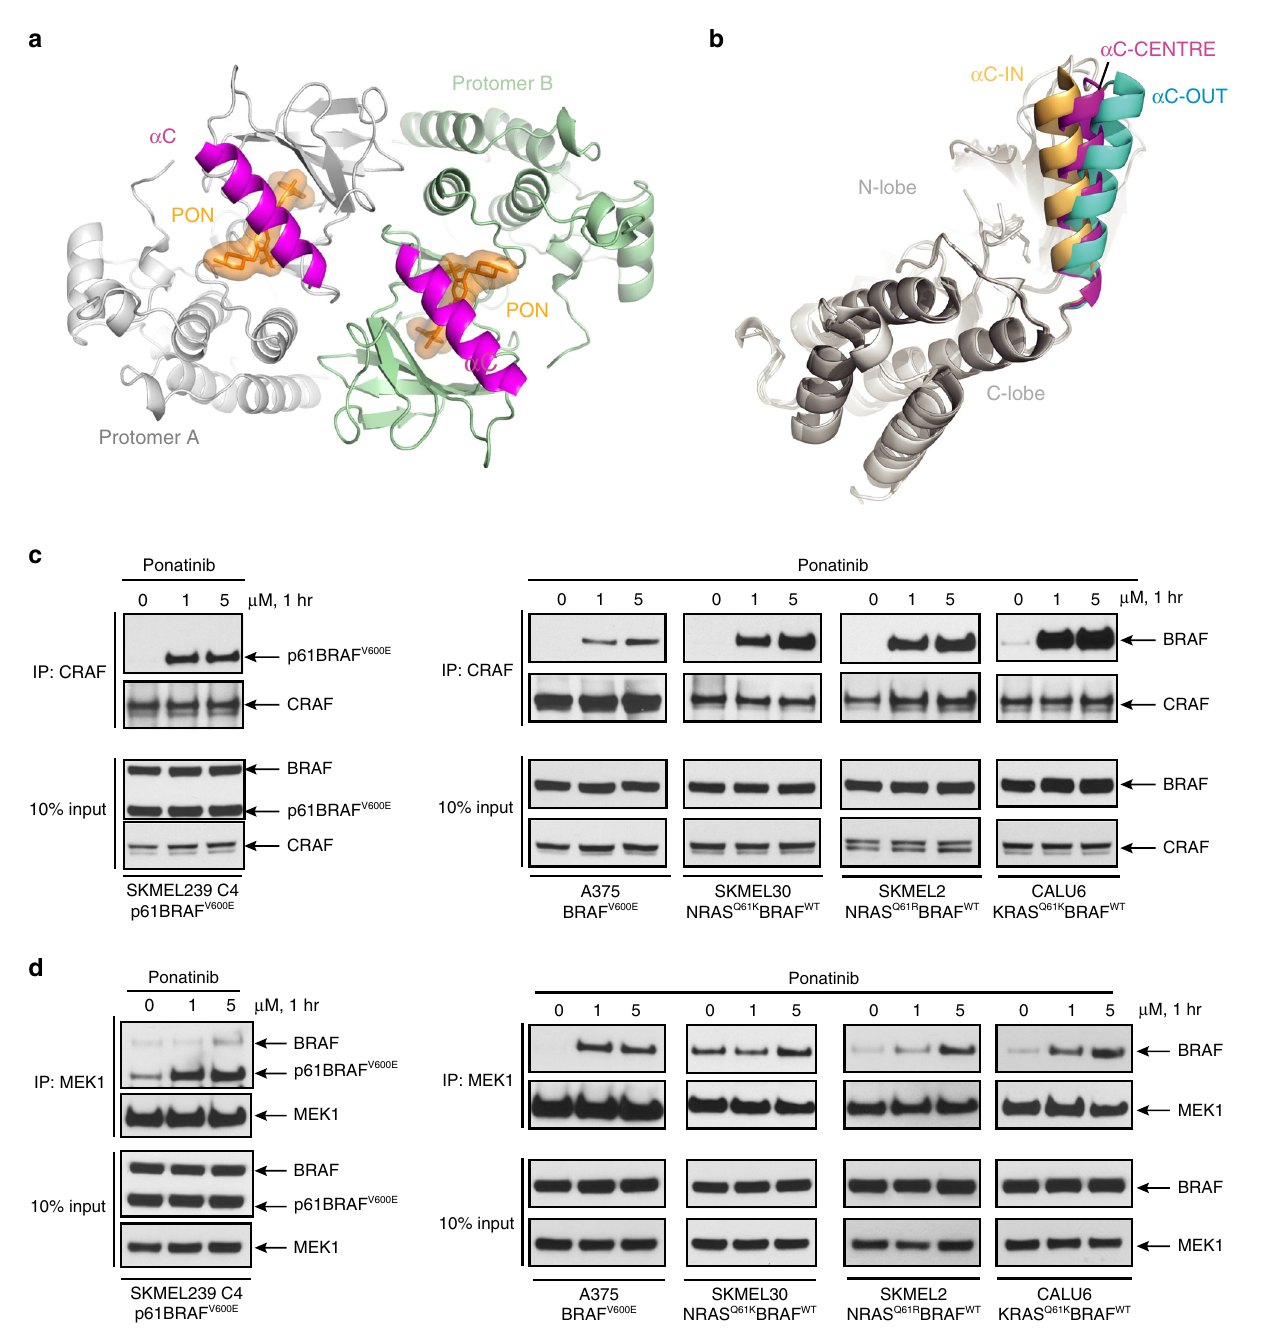
Fig. 3 Ponatinib induces symmetrical BRAF dimers and promotes BRAF complexes in cells. a The BRAF V600E /PON symmetrical dimer structure. The dimer is viewed along its twofold axis with two protomers in silver and green ribbon representations. PON bound to each protomer is shown in orange sticks/molecular surface. The α C-helix of each protomer is illustrated in magenta. b The α C-helix of BRAF V600E /PON complex adopts a α C-CENTRE position. Structural superposition of BRAF protomer structures in ribbon representation showing that α C-helix of BRAF-PON structure (magenta) lies between typical α C-OUT position observed in BRAF – Vemurafenib complex (cyan, PDB 3OG7) and α C-IN position in MEK-bound BRAF (gold, PDB 4MNE). Protein parts were omitted for clarity. c Various cell lines expressing BRAF V600E or RAS MUT /BRAF WT were left untreated or treated with 1 or 5 μ M Ponatinib for 1 h. Cells were then collected, assayed for CRAF by immunoprecipitation and immunoblot with the indicated antibodies for monitoring BRAF/ CRAF heterodimerization and activation of ERK signaling. d Similar analysis to c assayed for MEK by immunoprecipitation and immunoblot with the indicated antibodies for monitoring BRAF/MEK complex formation. Data are representative of n = 3 independent experiments. Source data are provided as a Source Data fi